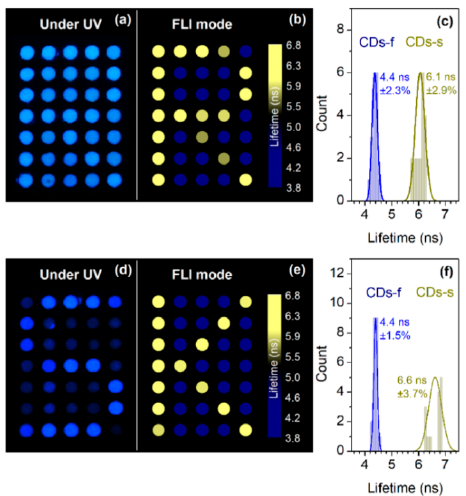
Figure 9. Images printed with C-dot inks and viewed under fluorescence imaging ( a , d ) and fluorescence lifetime imaging ( b , e ). In ( a ), all pixels have the same concentration of C-dots, while in ( d ), the concentration varies. ( b ) and ( e ) show the clear differentiation in fluorescence lifetime between CDs-f and CDs-s, irrespective of C-dot concentration. Histograms ( c ) and ( f ) show clear separation of fluorescence lifetimes with narrow distributions and no observable overlap. Reproduced with permission from reference [58], ACS Applied Materials and Interfaces; published by ACS Publishing,